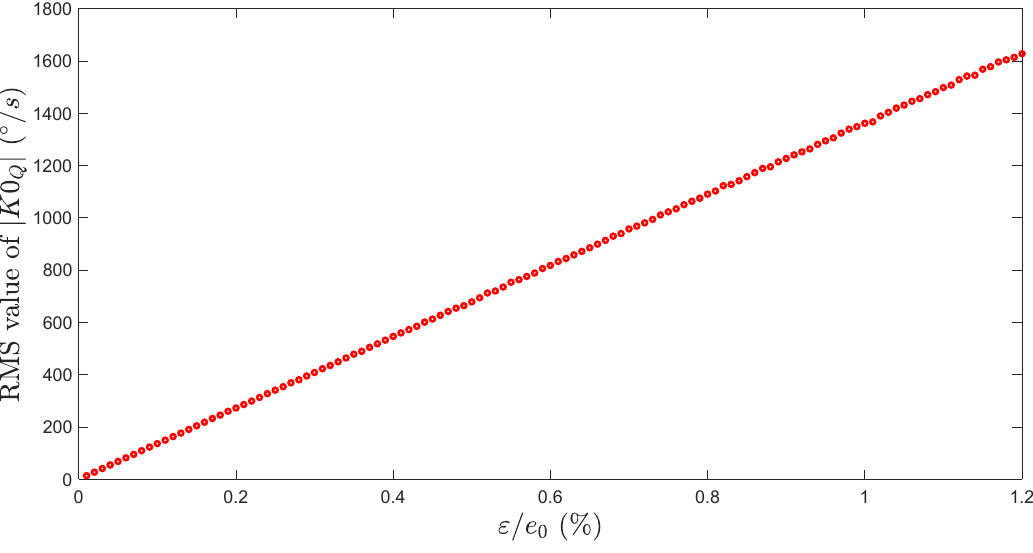
(cid:12) (cid:12) vs. standard deviation of the beam width Q